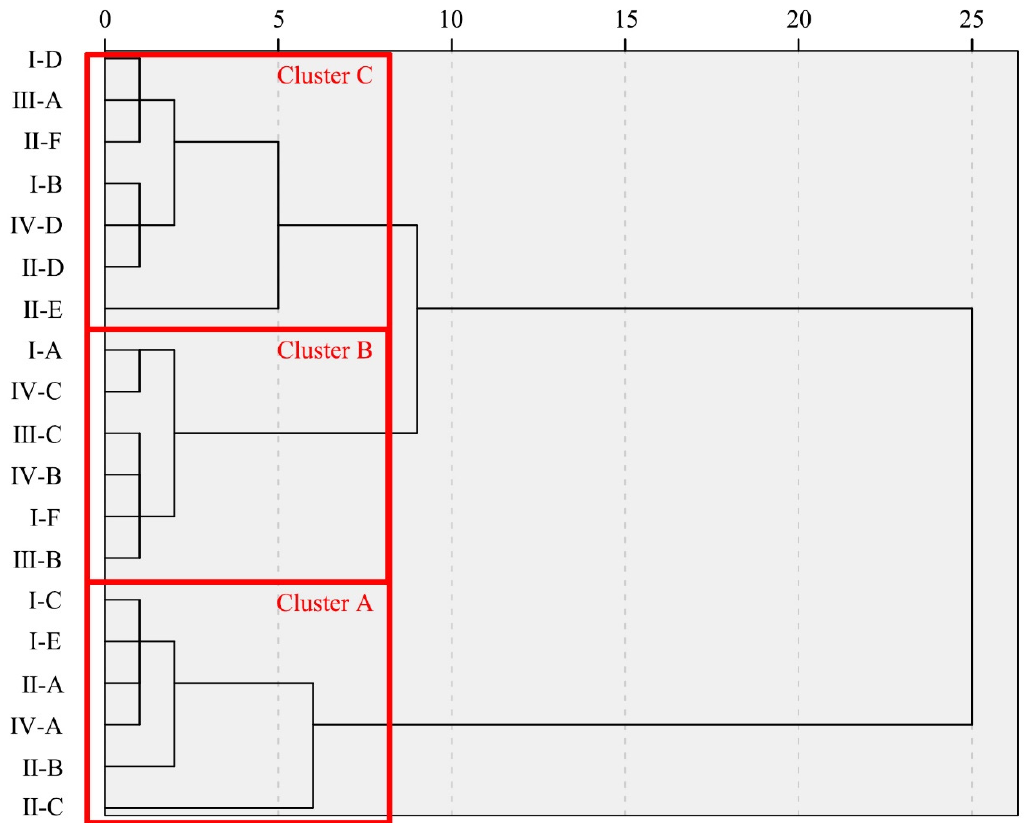
Table 1. Chi-square test of eye-tracking measures and subjective ratings of visual attributes.